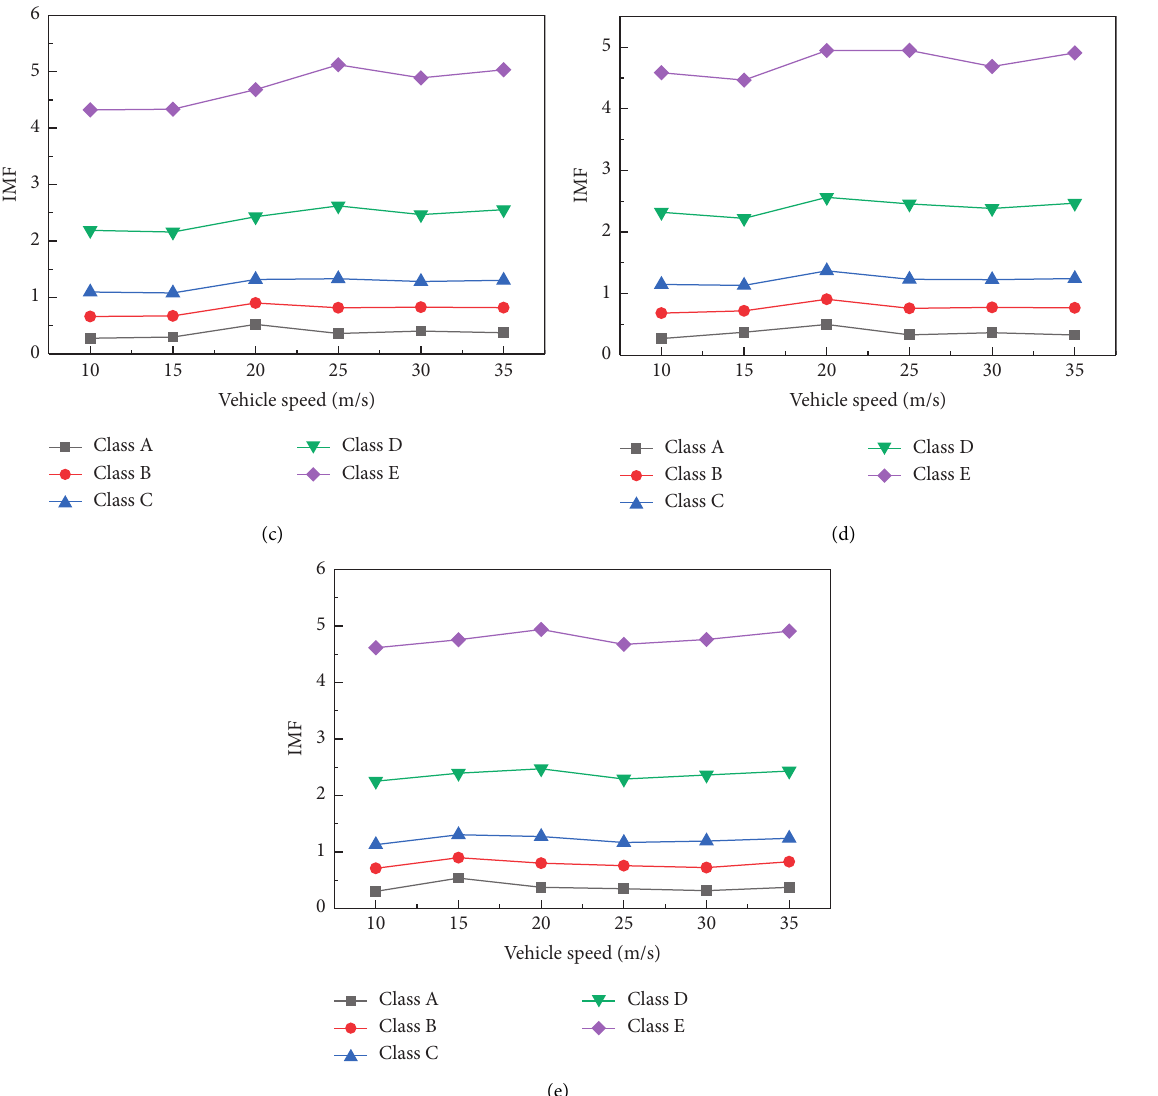
Figure 11: IMF under different cases: (a) 20m span; (b) 22.5 m span; (c) 25 m span; (d) 27.5m span; (e) 30m